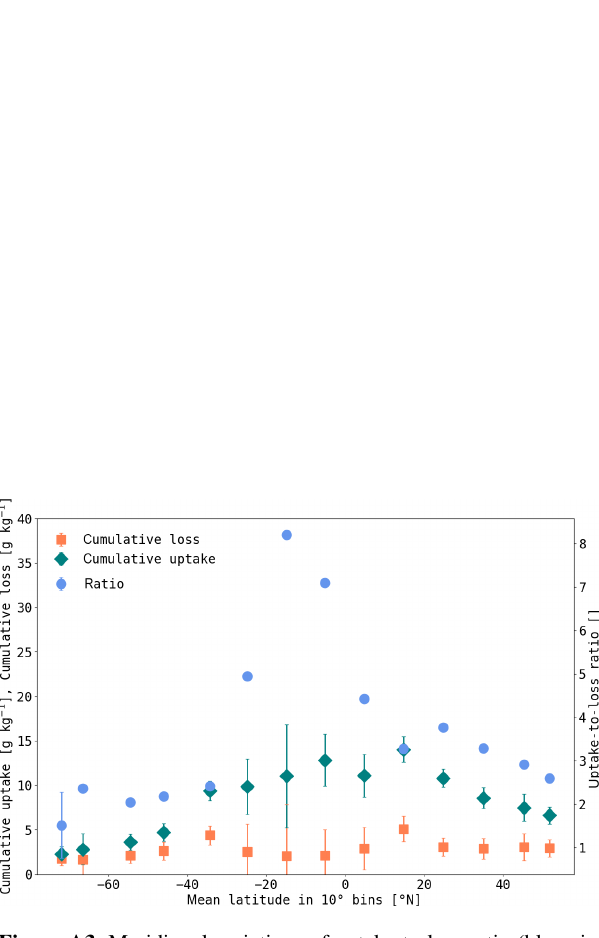
Figure A3. Meridional variations of uptake-to-loss ratio (blue cir- cles), cumulative loss (orange squares, gkg − 1 ) and cumulative up- take (green diamonds, gkg − 1 ) over the 5d prior to arrival at the measurement locations along backward trajectories. On the x axis, the mean latitude of the 10 ◦ bins is